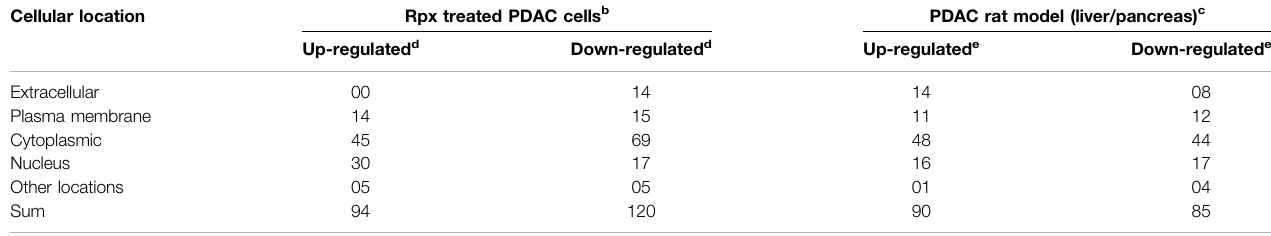
TABLE 1 | Cellular distribution of LSBP genes in Suit2-007 PDAC cells